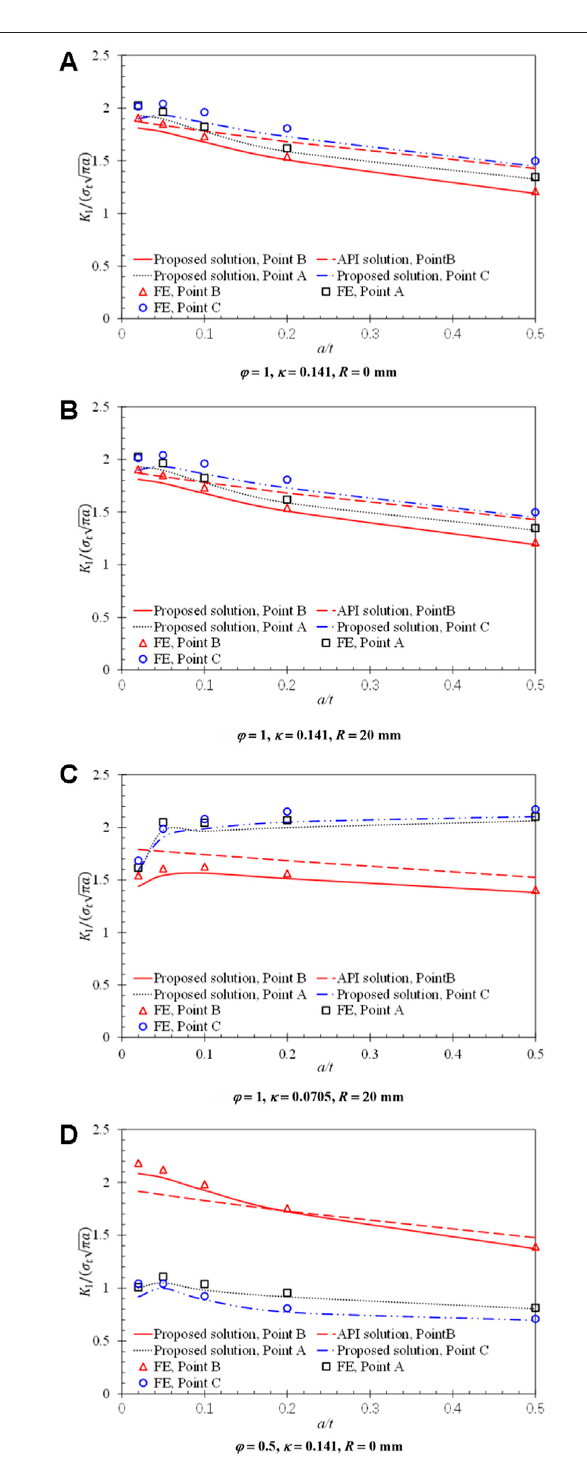
FIGURE11| Comparison ofSIFresultsobtainedusingvarious methods under internal pressure.